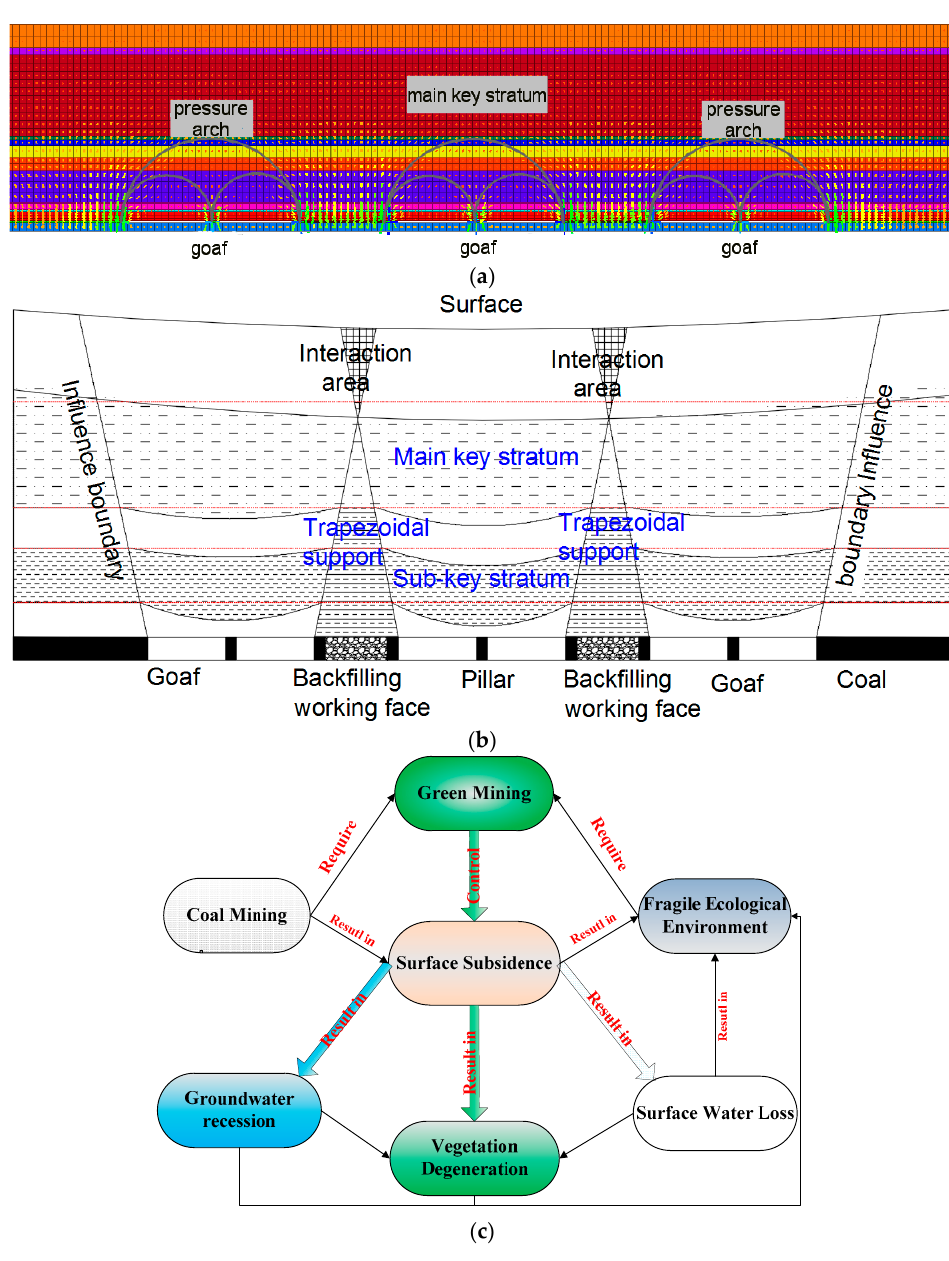
Figure 22. Control mechanism of the local filling–caving multi-faces coordinated mining; ( a ) distribution diagram of pressure arch. ( b ) Diagram of subsidence space transfer [50]. ( c ) Logic diagram of research content and geological environment.